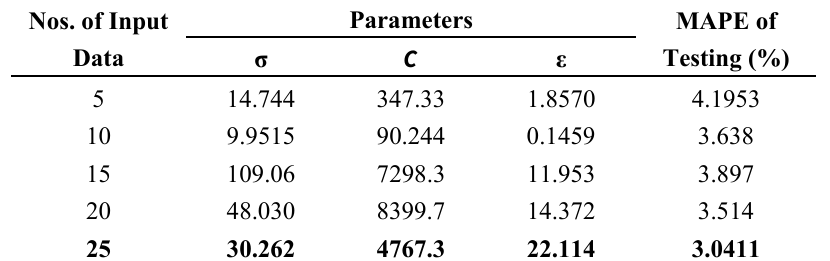
Table 4. Forecasting results and associated parameters of the SVRCIA